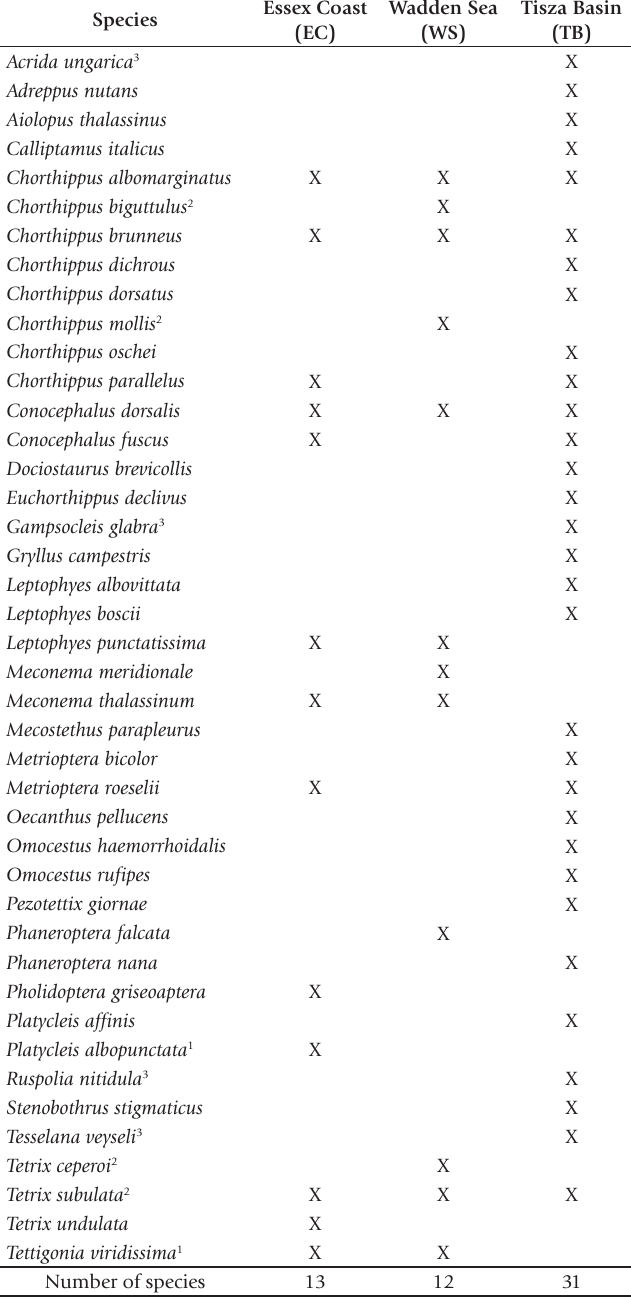
Table 1. Species of Orthoptera recorded from earth embankments in three areas of